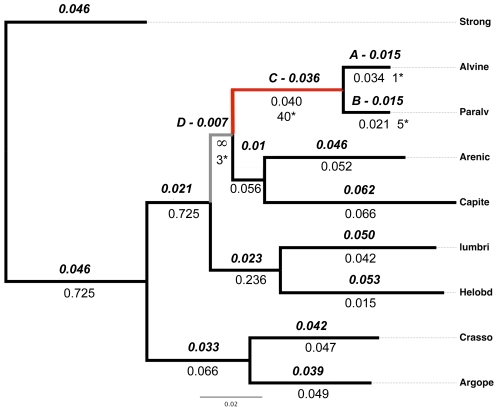
Maximum likelihood dN tree of lophotrochozoan invertebrates, including alvinellids and selective pressures among branches.The tree was obtained from a concatenated set of ribosomal protein orthologous sequences using the ProtML programme of PHYLIP with dN branches subsequently optimized by fitting the codon dataset on the Goldman & Yang (1994) codon substitution model [62] using the free-ω ratio model implemented in CodeML. Branch length (above the branch), and ω (below the branch) obtained from the free-ratio M1 model together with the number of positive codon sites with a BEB p-value>0.90 obtained from the M2A model.